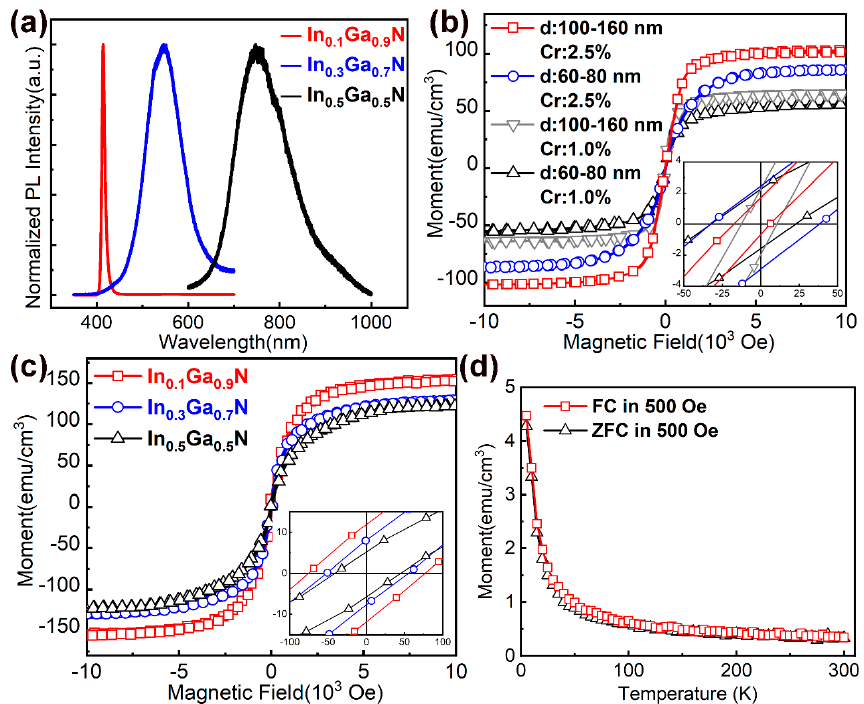
Figure 5. ( a ) Normalized photoluminescence (PL) spectra of In x Ga 1-x N (x = 0.1, 0.3, 0.5) nanostructures; ( b ) Magnetic properties of InN samples (Cr = 1.0% and Cr = 2.5%) with diameters of 60–80 nm and 100–160 nm on Si (111) substrates at 300 K. Inset shows hysteresis at lower fields; ( c ) Magnetic properties of In 0.1 Ga 0.9 N, In 0.3 Ga 0.7 N, and In 0.5 Ga 0.5 N nanostructures on Si (111) substrates at 300 K. Inset shows hysteresis at lower fields. ( d ) Zero field-cooled and field-cooled magnetization curves for the In 0.1 Ga 0.9 N nanorods.